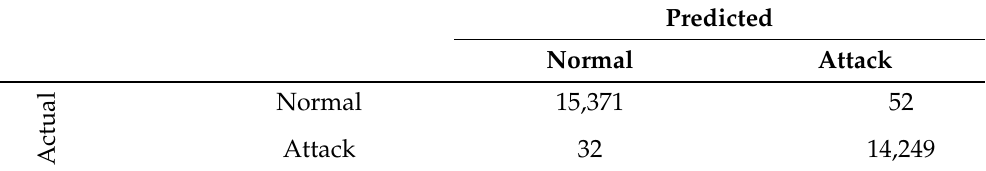
Table 7. Confusion matrix for NSL-KDD “modified distribution” binary classification experiment.